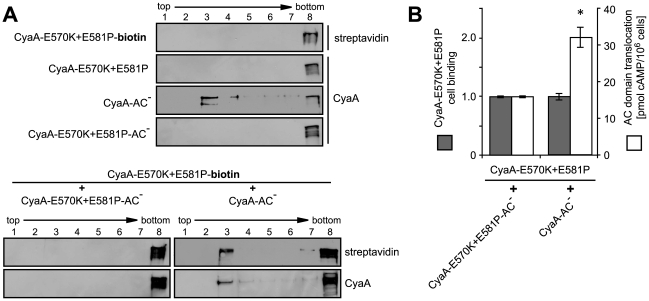
AC domain of CyaA translocates across cellular membrane from lipid rafts.(A) J774A.1 cells were incubated at 37°C for 10 min with 1 nM individual CyaA proteins (upper panel) or with their 1∶1 mixtures (lower panel). CyaA and biotinylated CyaA-E570K+E581P (CyaA-E570K+E581P-biotin) were detected in gradient fractions using 9D4 and streptavidine, respectively. (B) J774A.1 cells were incubated at 37°C for 10 min with the indicated pairs of proteins (12 nM) mixed in a 1∶1 molar ratio. Binding of CyaA-E570K+E581P-biotin was determined as the amount of total cell-associated AC enzyme activity upon exposure of cells to the protein mixtures and expressed as relative value. Enhancement of the residual capacity of CyaA-E570K+E581P to translocate AC domain into J774A.1 cell cytosol (1.8±0.5% of intact CyaA activity) was measured by determination of intracellular cAMP amounts accumulated in 106 cells upon exposure for 10 min at 37°C to the indicated 1∶1 protein mixtures (12 nM). The values represent the mean ± S.D. from four independent experiments performed in duplicate. An asterisk indicates a statistically significant difference (*, p<0.01; Student's t test).